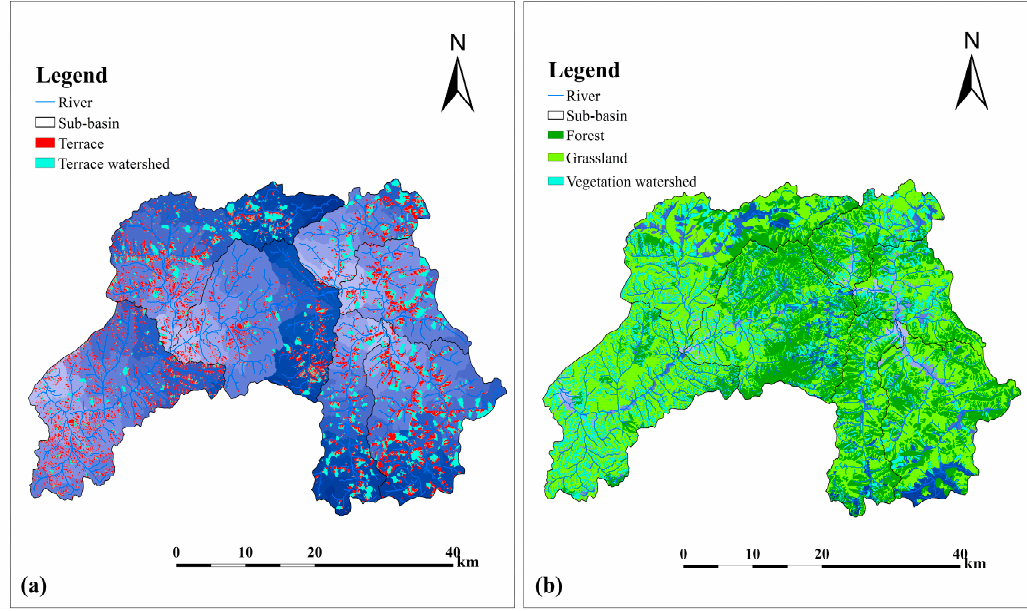
Figure 6. Extraction of terrace watershed ( a ) and vegetation watershed ( b ) of Pianguanhe in 2010s.